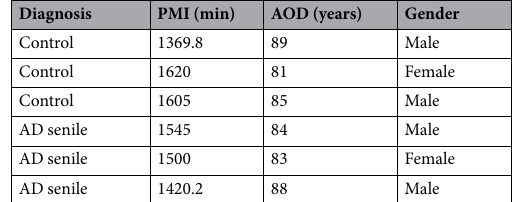
Table 3. Characteristics of the subjects from the Douglas-Bell Canada Brain Bank (DBCBB) samples. Abbreviations in Table: PMI(min): post-mortem interval in minutes; AOD: age of death.